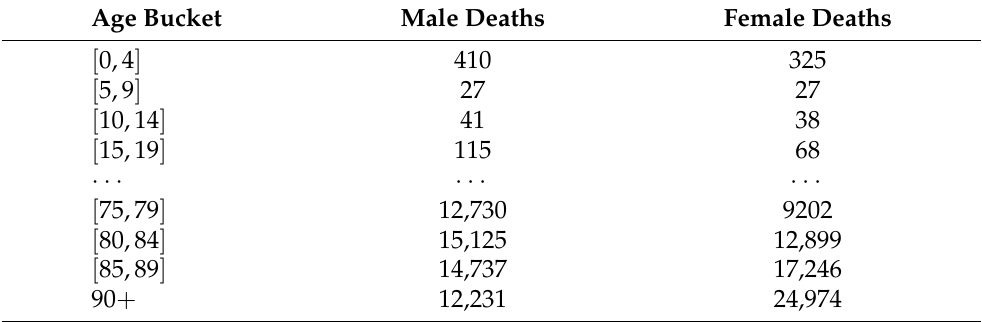
Table A3. The male and female Belgian death counts in 2020 in age buckets, obtained from